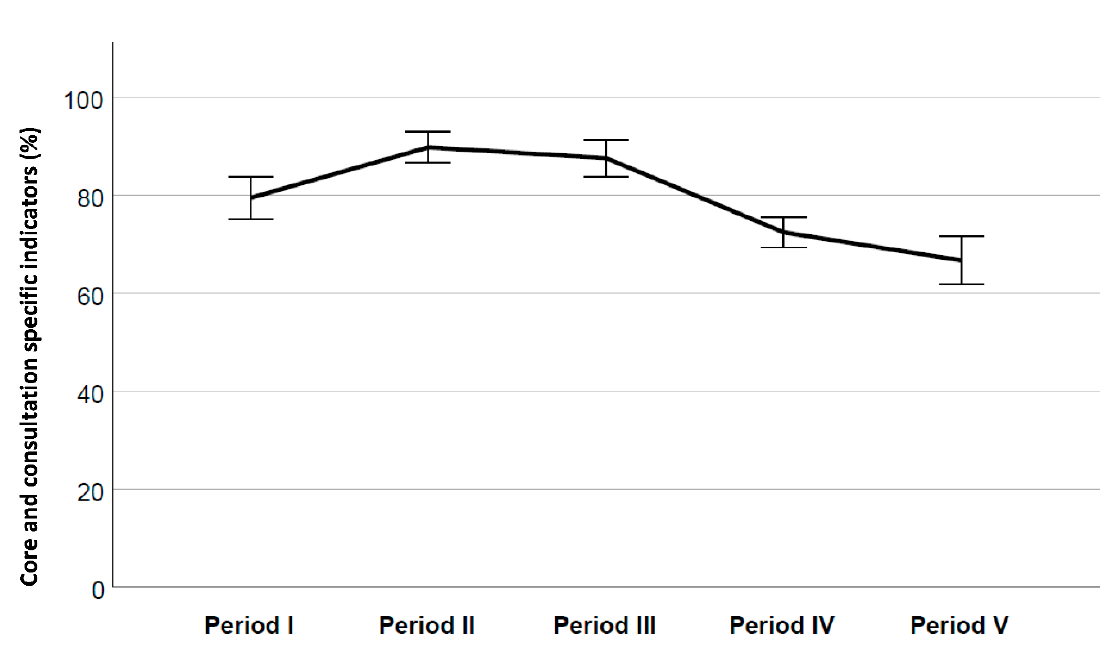
Figure 3. Overall program fulfilment by period, core and consultation specific indicators combined.